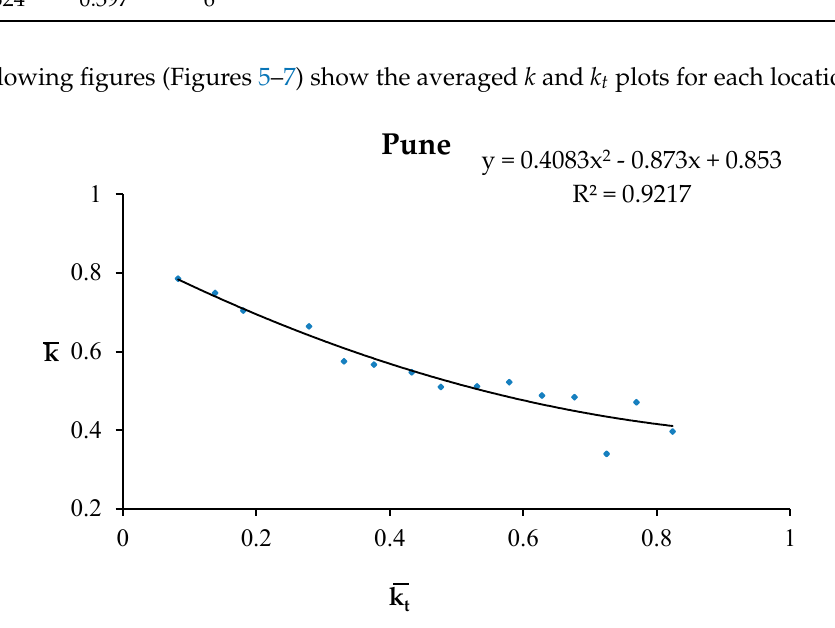
Figure 4. Monthly ‐ averaged hourly k t vs. k for Aughton.